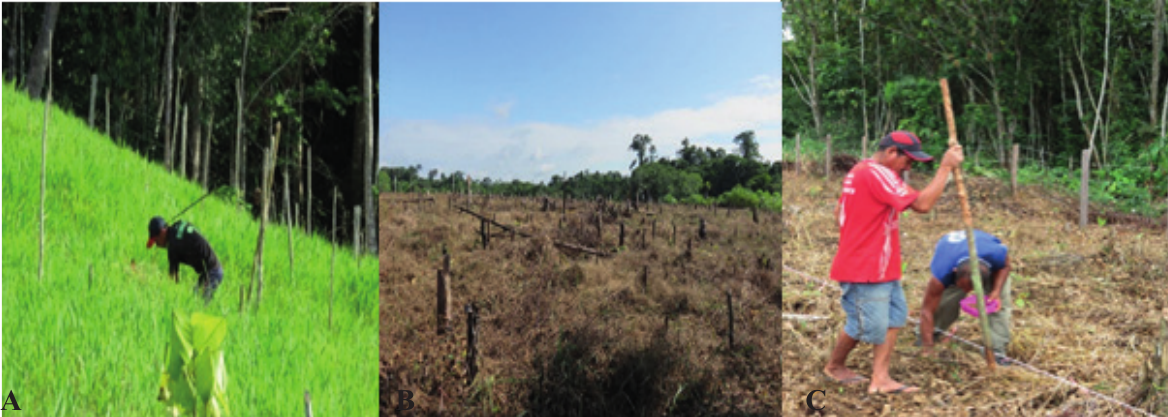
Figure 1. Picture of a) initial degraded pasture with Brachiaria, b) after burning with herbicide, and c) planting cover crop with